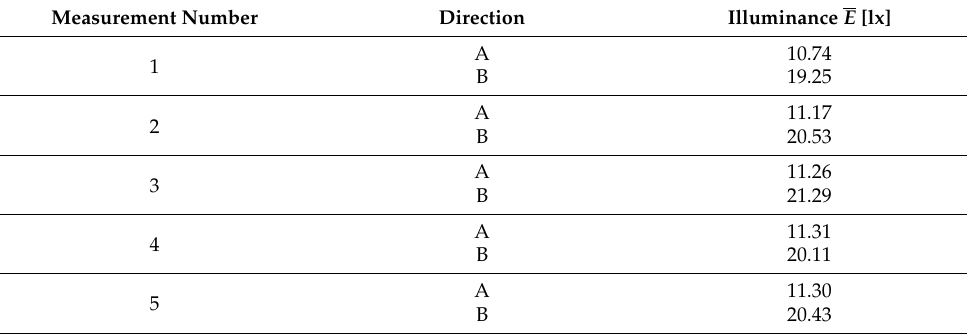
Table A3. Example of the results for measurement field No. 5.